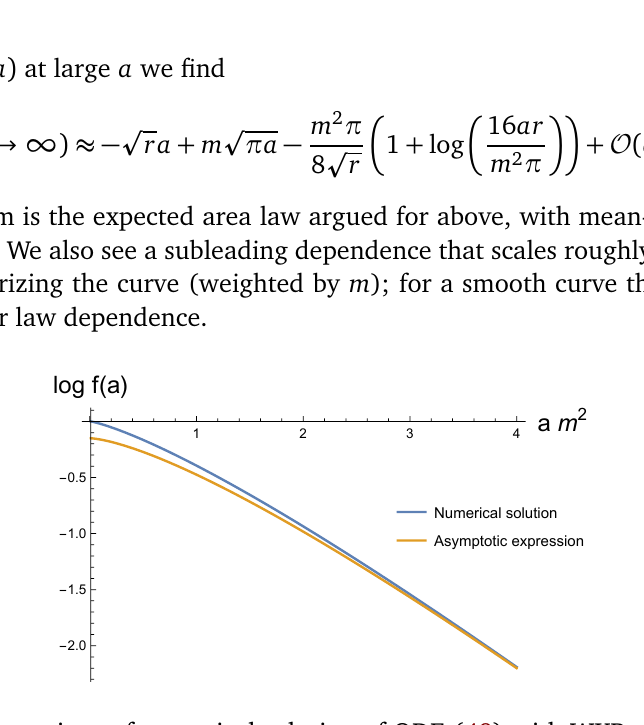
Figure 3: Comparison of numerical solution of ODE (48) with WKB asymptotic ap- proximation (50) for rm − 4 = 1. Integration constant in the asymptotic expression has been adjusted for agreement at large a